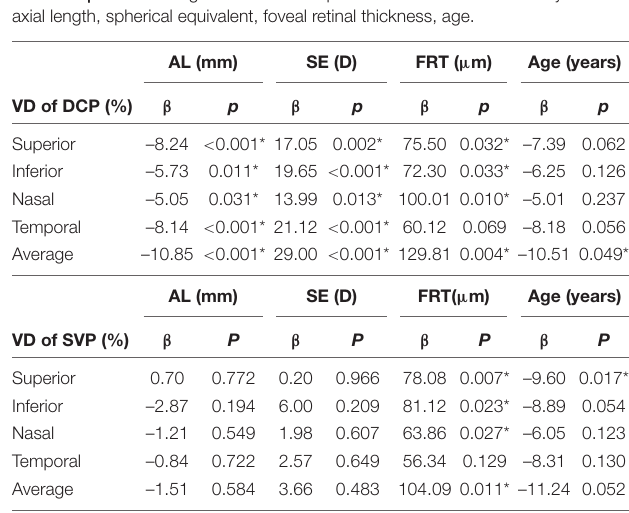
β /P value: Regression coefficient and p values of the independent variables were calculated by GEEs. The influence factors as age and/or sex have been adjusted. VD, vessel density; DCP, deep capillary plexus; SVP, superficial vascular plexus. ∗ Significance of difference.